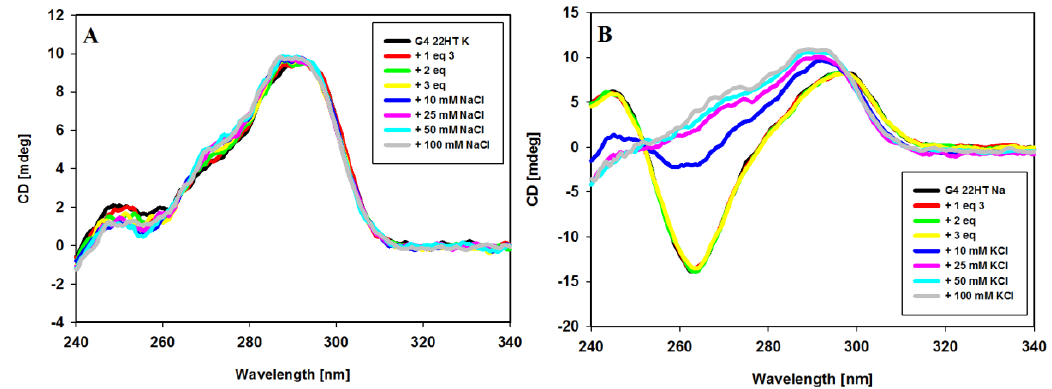
Figure 10. CD spectra of G-quadruplex 22HT (3µM) in the cation replacement experiments. Conditions: Tris-HCl buffer (10 mM, pH 7.2) containing 100 mM NaCl ( A ) and 100 mM KCl ( B ) with increasing amounts of ligand 3 and subsequent increasing amounts of competing cation.